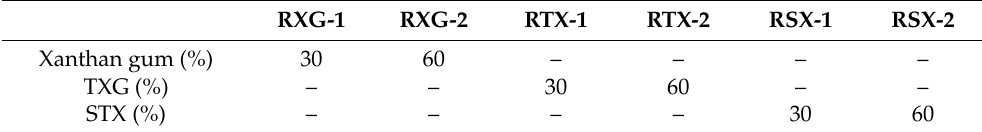
Table 2. Formulation of repaglinide gastro retentive mucoadheisve tablets *.